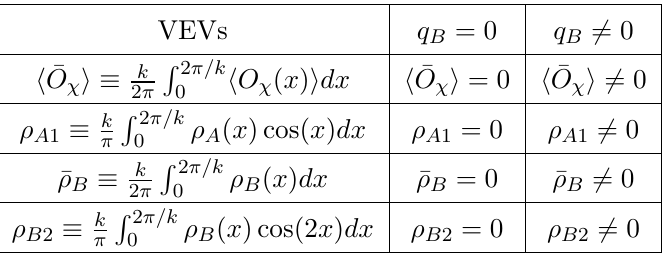
Table 1 . Comparison of various VEVs between q B = 0 and q B 6 = 0. The former case corresponds to PDW order, while the latter to a state with co-existing SC+CDW